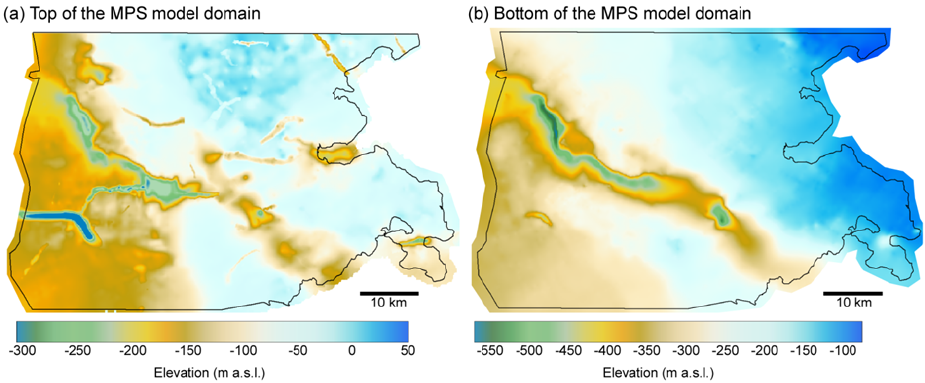
Figure 5. Elevation of the top and bottom of the MPS model domain (the Miocene unit). (a) The modelled surface defining the top of the MPS model domain. The surface is obtained by merging the bottom of the Måde Group and the top pre-Quaternary (see Fig. 4). (b) The modelled surface of the bottom of the MPS model domain, which consists of the top Paleogene clay. Note different colour